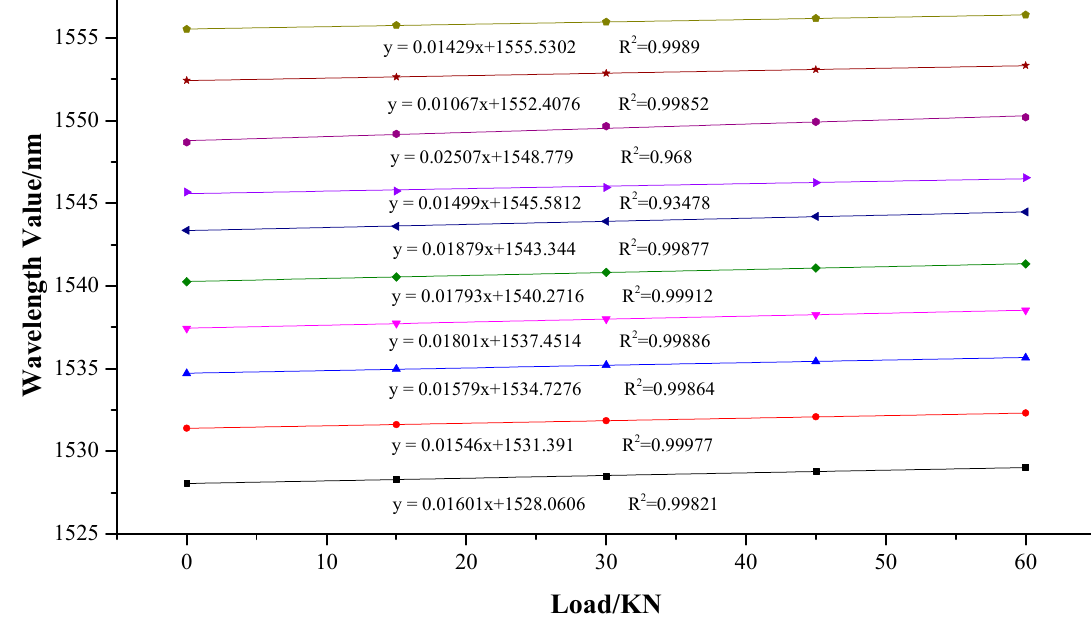
Figure 8. Fitting analysis of loading test results.